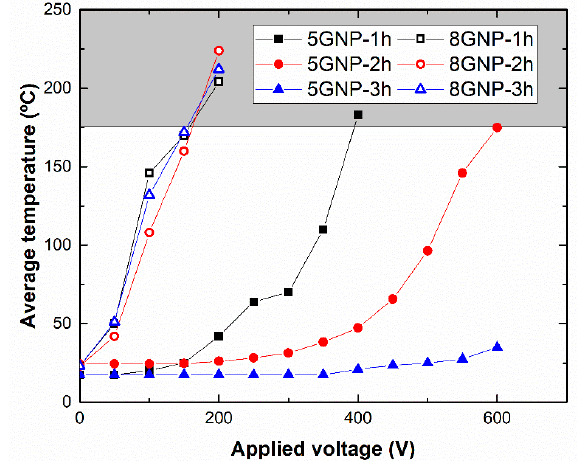
Figure 6. Average temperature reached as a function of the applied voltage for each tested condition (grey-colored area indicates the degradation zone of the epoxy resin).